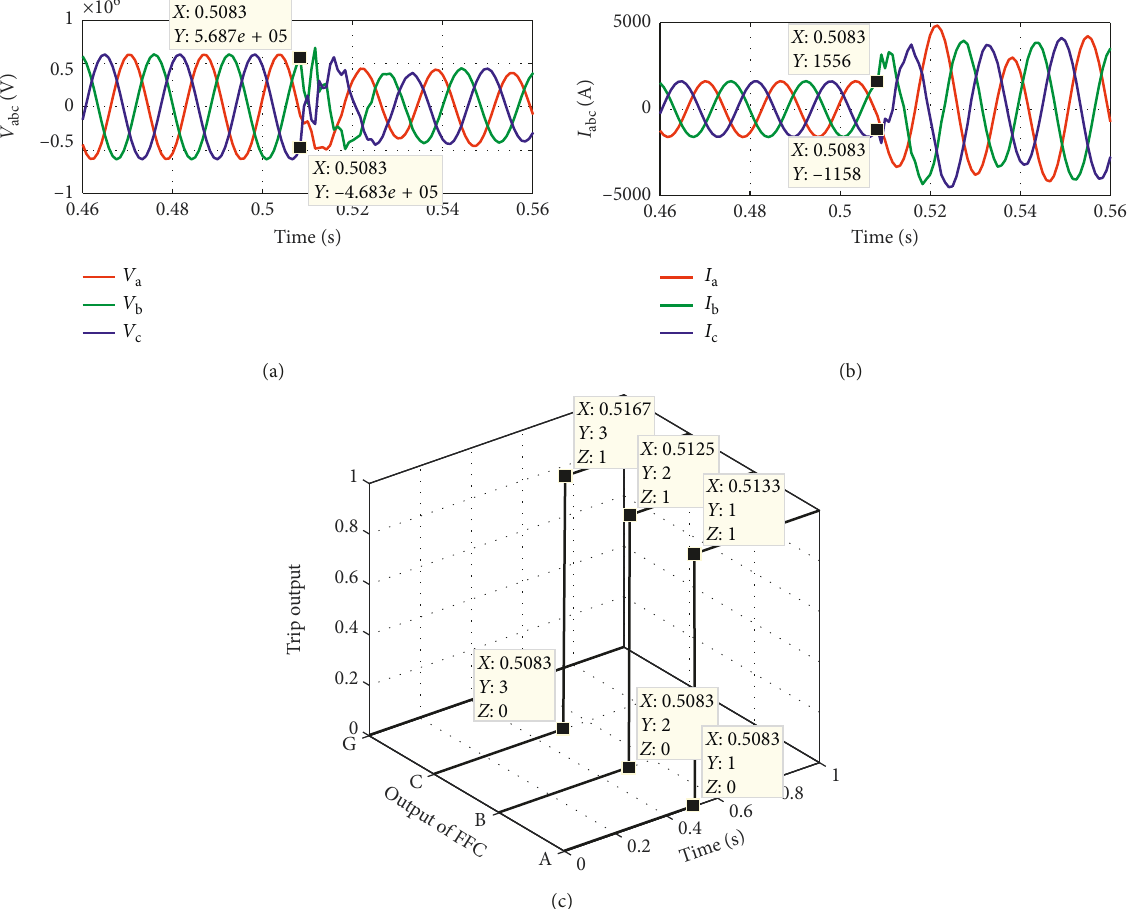
Figure 6: Performance during ABC fault at 175km, FIA � 180 ° , and FR � 50 Ω : (a) 3-phase voltage waveform; (b) 3-phase current waveform; (c) output of Table 7: Effect of fault type (FR � 50 Ω and FIA � 45 ° ). Simulated system data